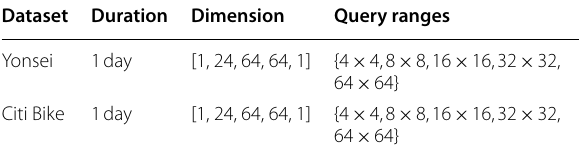
Table 3 Parameters of test data and query ranges Dataset Duration Dimension Query ranges